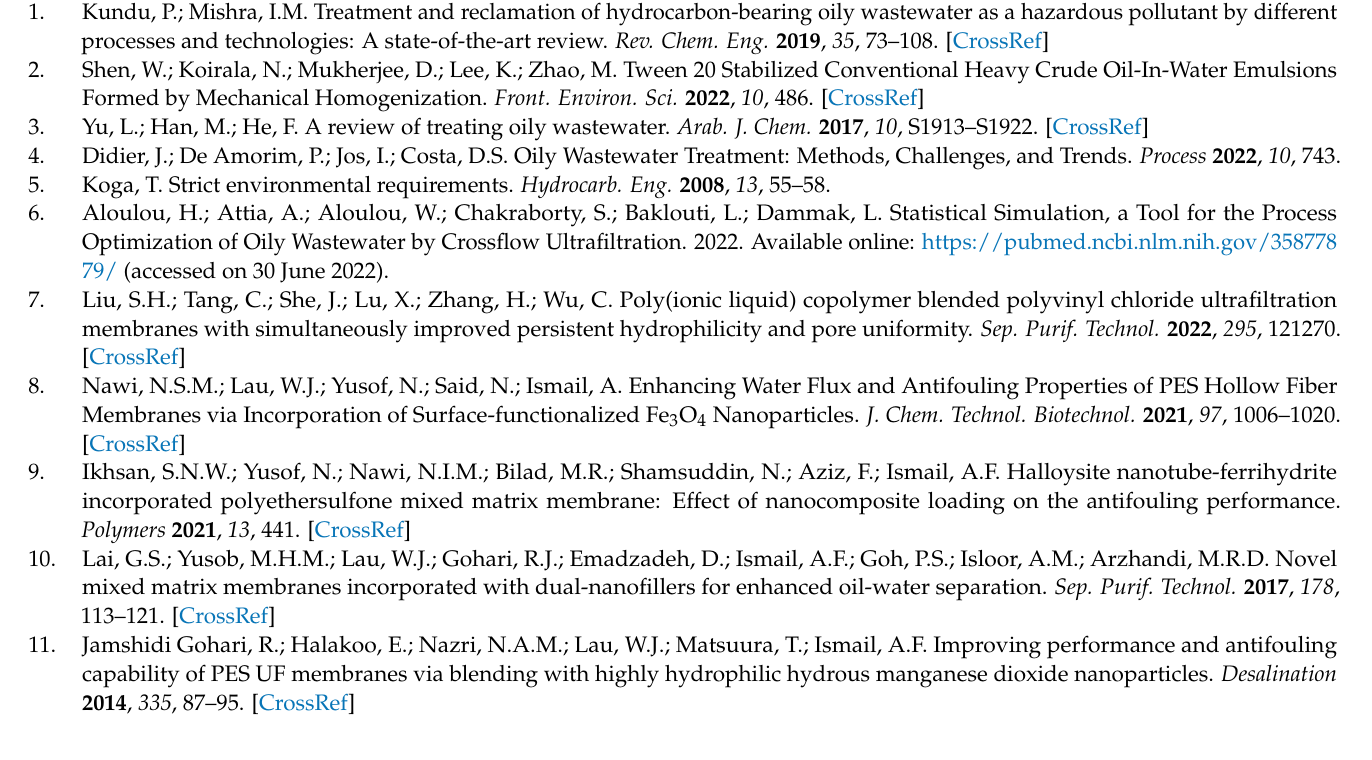
Table S1: Membrane thickness, porosity and mean pore